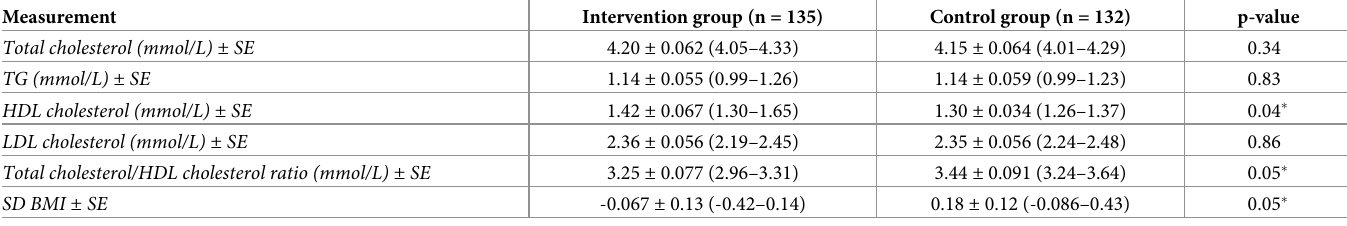
� indicates a significant p-value when p < 0.05. SE (Standard